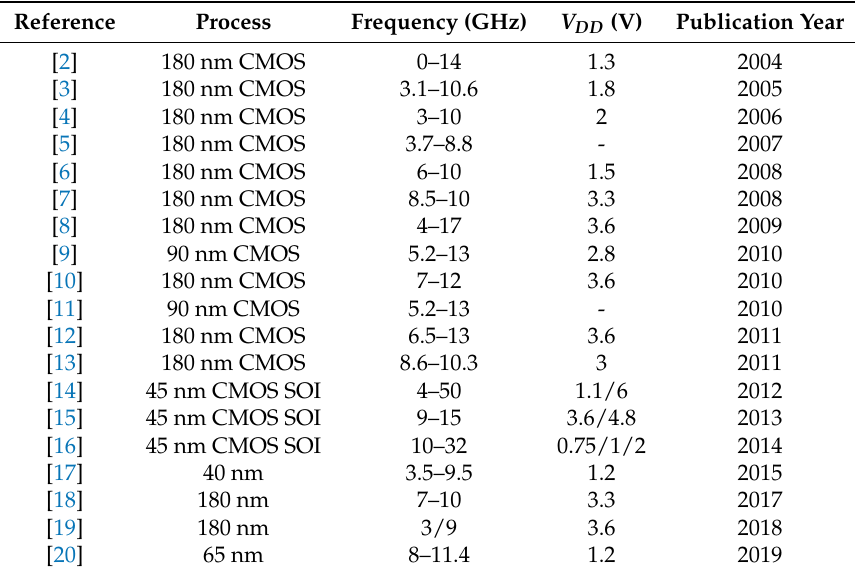
Table 1. Lists of publications about CMOS power amplifiers covering X-band